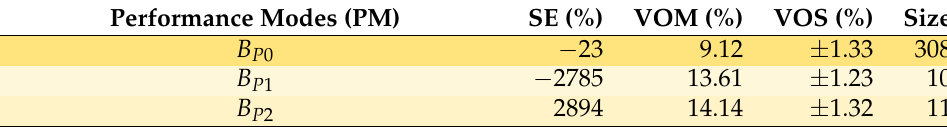
Table 9. Performance modes identified after receiving chunk 3.